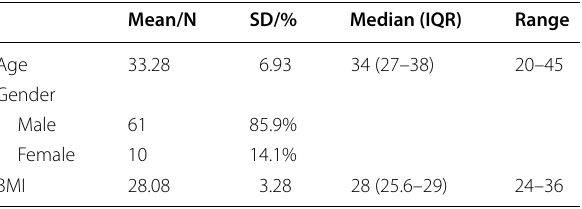
Table 1 Age, gender and BMI distribution of the patients participating in the study